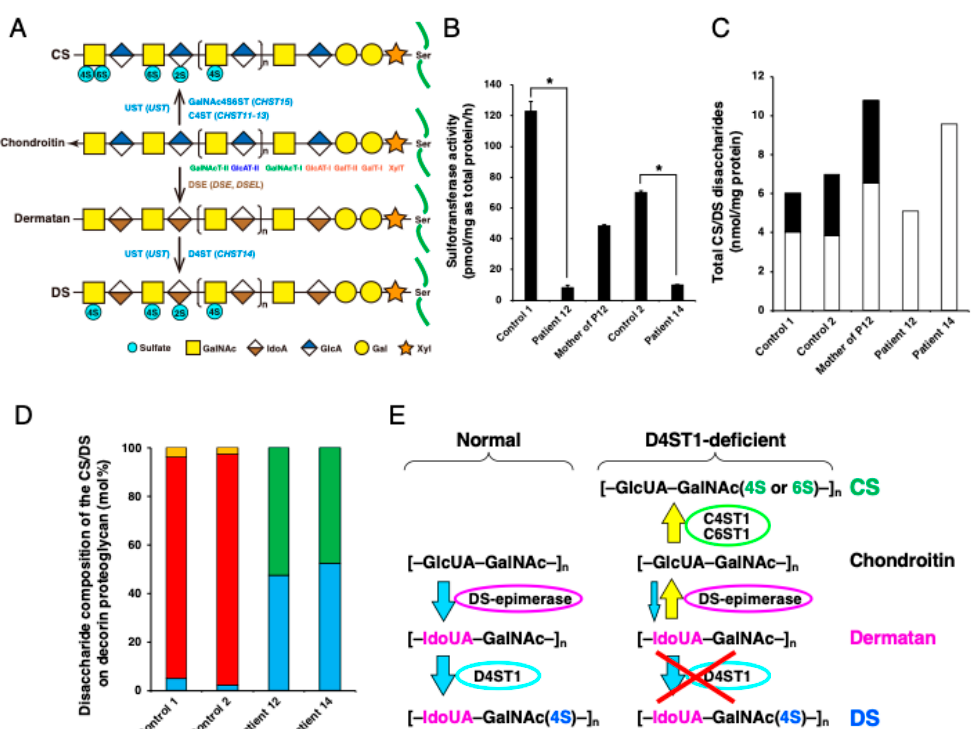
Figure 3. Biosynthesis of CS / DS and glycobiological analysis in mcEDS- CHST14 . ( A ) Biosynthetic assembly of CS and DS chains by glycosyltransferases, epimerases, and sulfotransferases. It starts with the biosynthesis of a tetrasaccharide linker region, glucuronic acid- β 1,3-galactose- β 1,3-galactose- β 1,4-xylose- β 1- O -(GlcUA-Gal-Gal-Xyl-), onto serine residues of specific core proteins of PGs by β -xylosyltransferase (XylT), GalT-I, GalT-II and β 1,3-glucuronosyltransferase-I (GlcAT-I), respectively. Subsequently, a repetitive disaccharide region [ N -acetyl- D -galactosamine(GalNAc)-GlcUA)] n of chondroitin is elongated by the actions of N -acetyl- D -galactosaminyltransferase-I (GalNAcT-I), N -acetyl- D -galactosaminyltransferase-II (GalNAcT-II) and glucuronyltransferase-II (GlcAT-II), which are encoded by CS N -acetylgalactosaminyltransferase-1 and -2, chondroitin synthase-1, -2, and -3 and chondroitin polymerizing factor genes. Chondroitin chains are matured to CS through modifications by chondroitin 4- O -sulfotransferase (C4ST), chondroitin 6- O -sulfotransferase (C6ST) and uronyl 2- O -sulfotransferase (UST). A disaccharide-repeating region of dermatan is synthesized through epimerization of a carboxyl group at C5 from GlcUA to IdoUA by DSE. A mature DS chain is synthesized through modification with sulfation by D4ST1 and UST. ( B ) Sulfotransferase activity toward dermatan in fibroblast cultures of skin from two patients with mcEDS- CHST14 (patient 12 with heterozygous variants Pro281Leu / Tyr293Cys; patient 14 with a homozygous variant Pro281Leu), the mother of patient 12, and a sex- and age-matched healthy volunteer [6]. * p < 0.0001 by two-tailed unpaired t -test. ( C ) Total amounts of CS and DS derived from fibroblast cultures of skin [6]. Total disaccharide contents of CS (white box) and DS (black box) were calculated based on the peak area in the chromatograms of the digests with chondroitinase AC and chondroitinase B, respectively. ( D ) Proportion of the disaccharide units in the CS-DS hybrid chain in decorin-PGs secreted by the fibroblasts [6]. Cyan, green, red and orange boxes are GlcUA-GalNAc(4S), GlcUA-GalNAc(6S), IdoUA-GalNAc(4S), and IdoUA(2S)-GalNAc(4S), respectively. Abbreviations of 2S, 4S and 6S indicate 2- O -, 4- O - and 6- O -sulfate, respectively. ( E ) Schematic diagram of the biochemical mechanism in the replacement of DS by CS in mcEDS- CHST14 . Defect in D4ST1 enables a back-epimerization reaction that converts IdoUA back to GlcUA to form chondroitin by DSE, followed by the 4- O -sulfation and / or 6- O -sulfation of GalNAc residues in chondroitin by C4ST1 and C6ST1, respectively. (B–D, reproduced from Miyake et al. Hum. Mutat. 2010 , 31 , 1233–1239, with permission from Wiley-Liss,